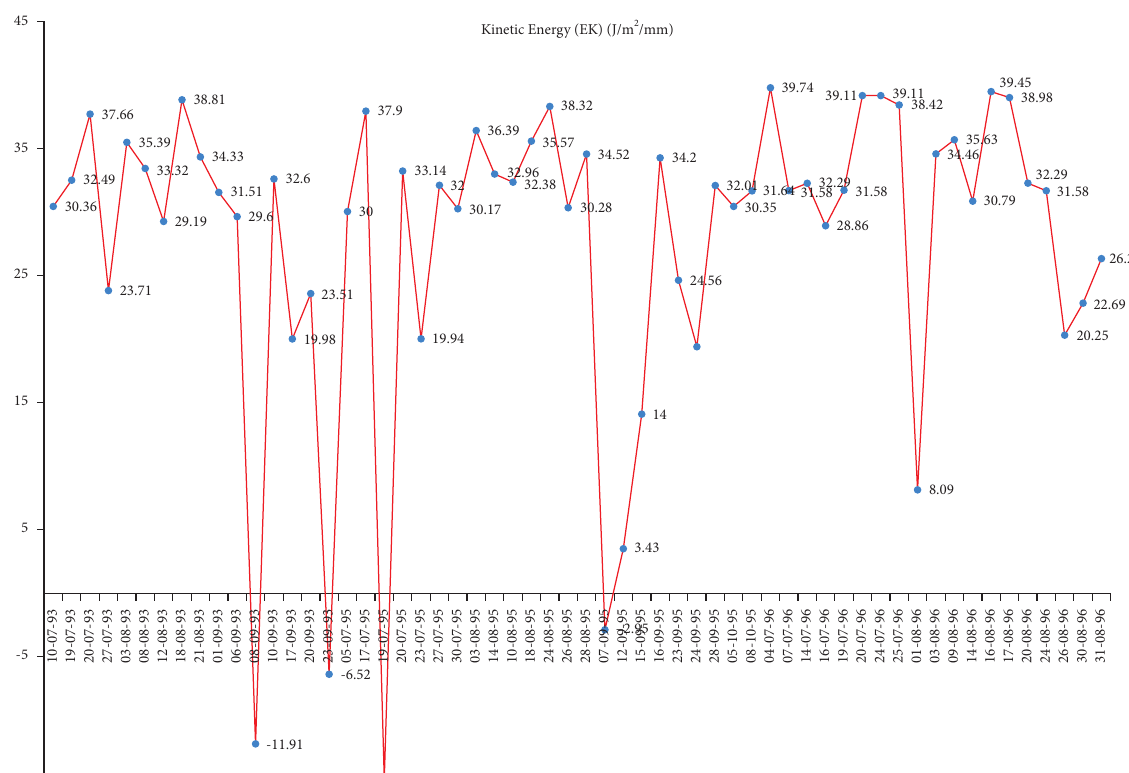
Figure 4: Average raindrop kinetic energy with the selected dates of